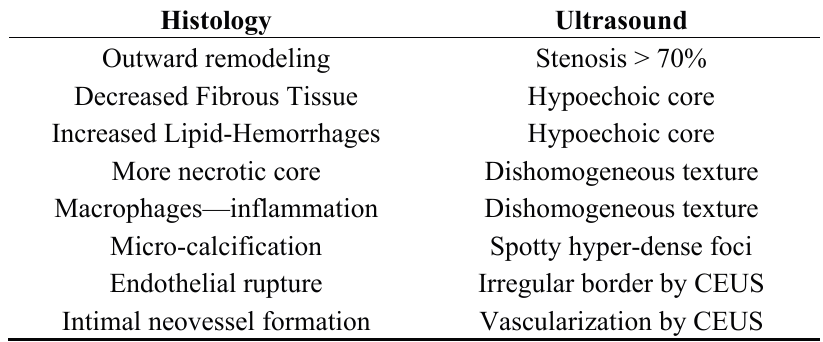
Table 1. The vulnerable plaque read-out: from histology to